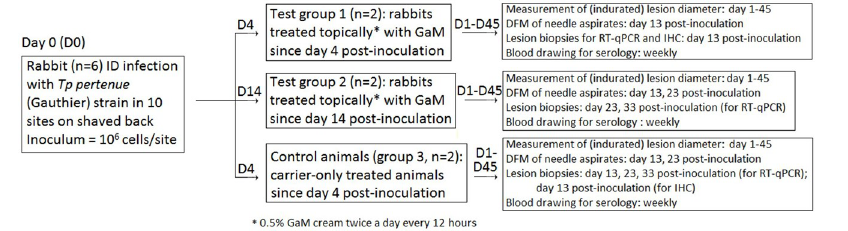
Fig 1. Flowchart of the experimental design and